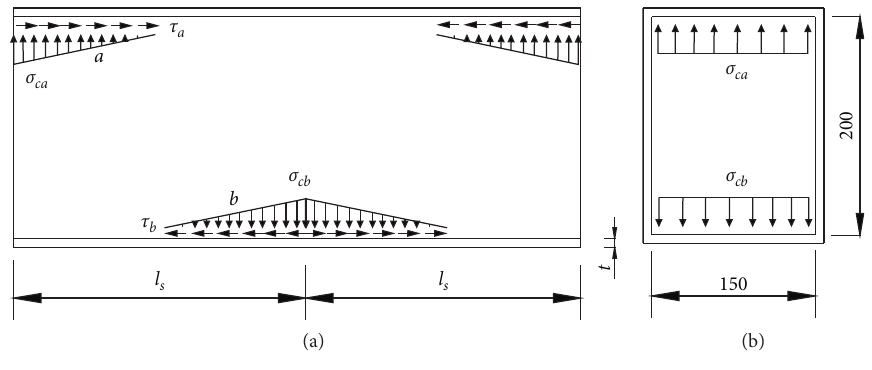
Figure 21: Stress condition of pure steel hoop.